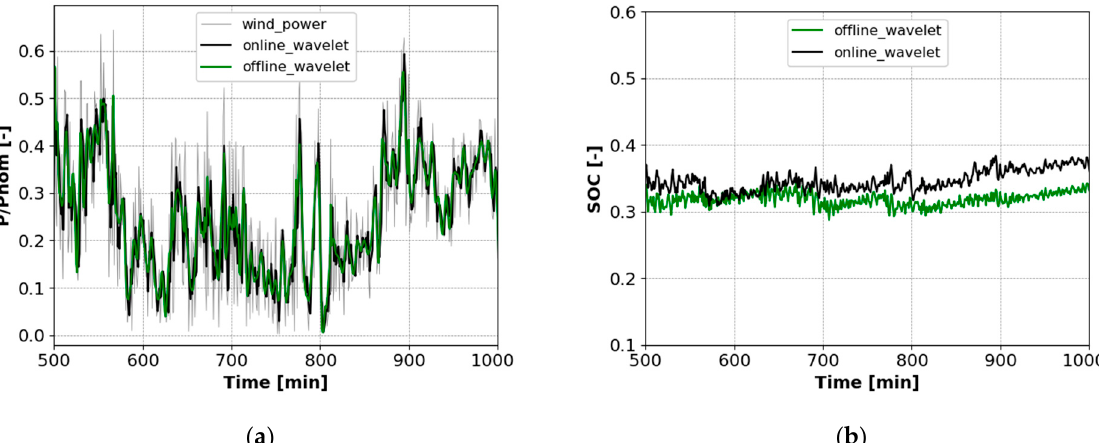
Figure 26. Online vs. Offline: ( a ) Power fed into the grid ( b ) SOC profile.